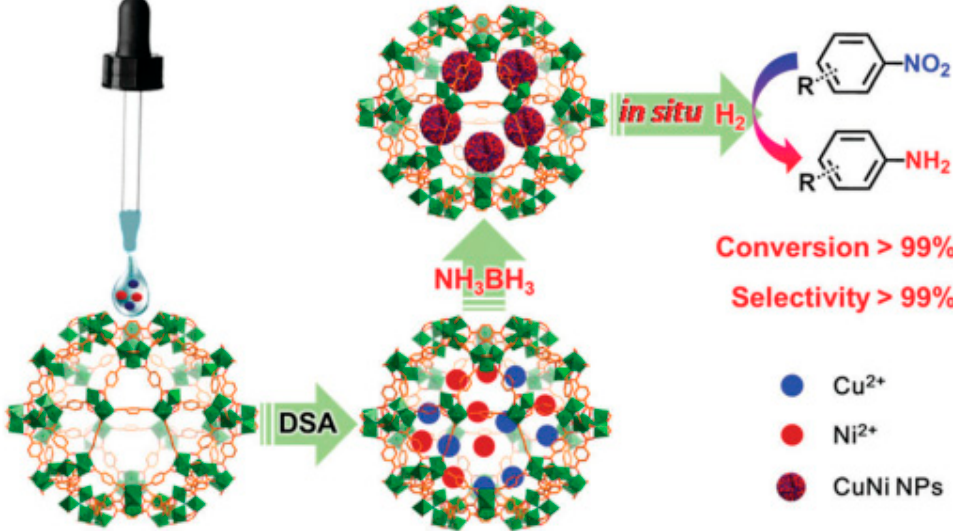
Figure 15. Preparation procedure of CuNi@MIL-101(Cr) by the DSM and its use as catalyst for a cascade reaction involving dehydrogenation of NH 3 BH 3 and hydrogenation of nitroarenes. Reproduced with permission from [64].